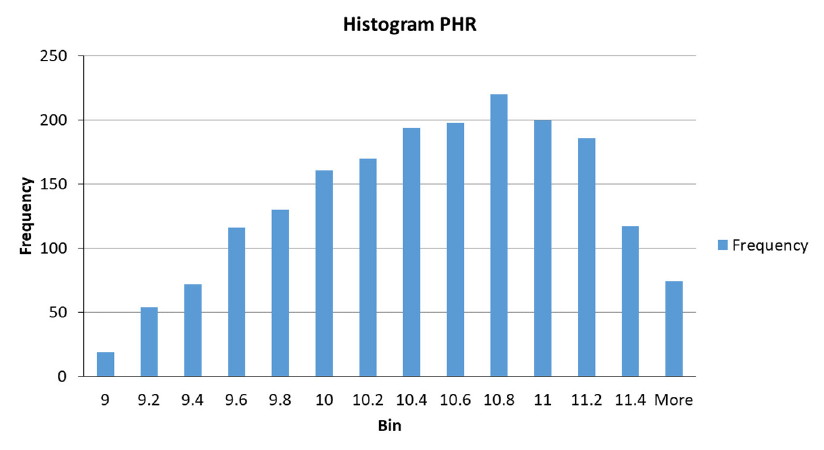
Figure A8. pH value of the pulp in rougher flotation stage (PHR)—dataset distribution.